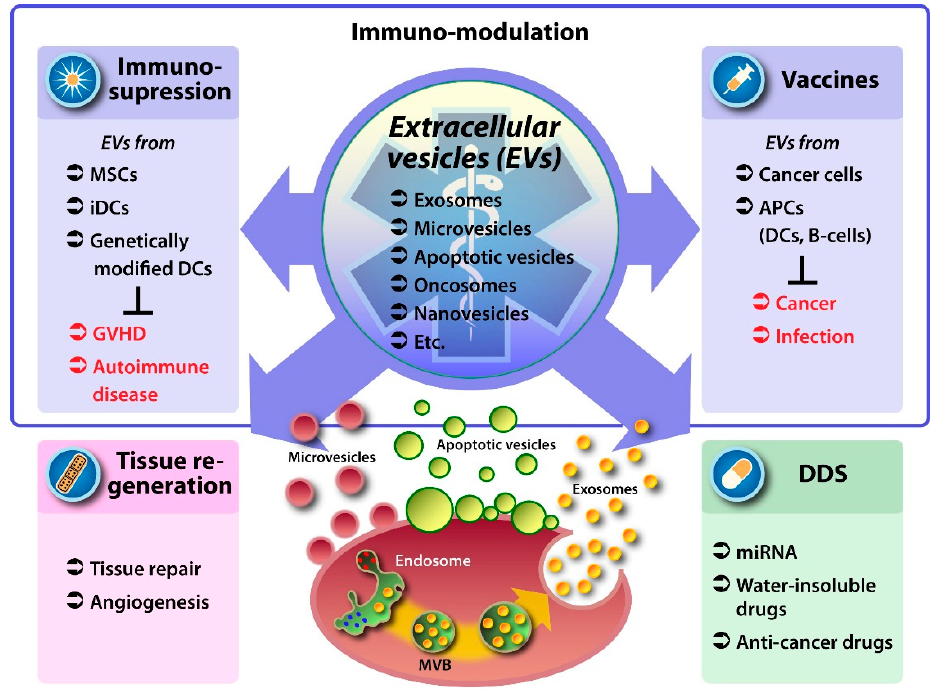
Figure 1. Research aimed at developing extracellular vesicles (EVs) for clinical applications. APC: Antigen presenting cell; DCs: Dendritic cells; iDCs: Immature dendritic cells; DDS: Drug delivery system; GVHD: Graft-versus-host disease; MSCs: Mesenchymal stem cells.